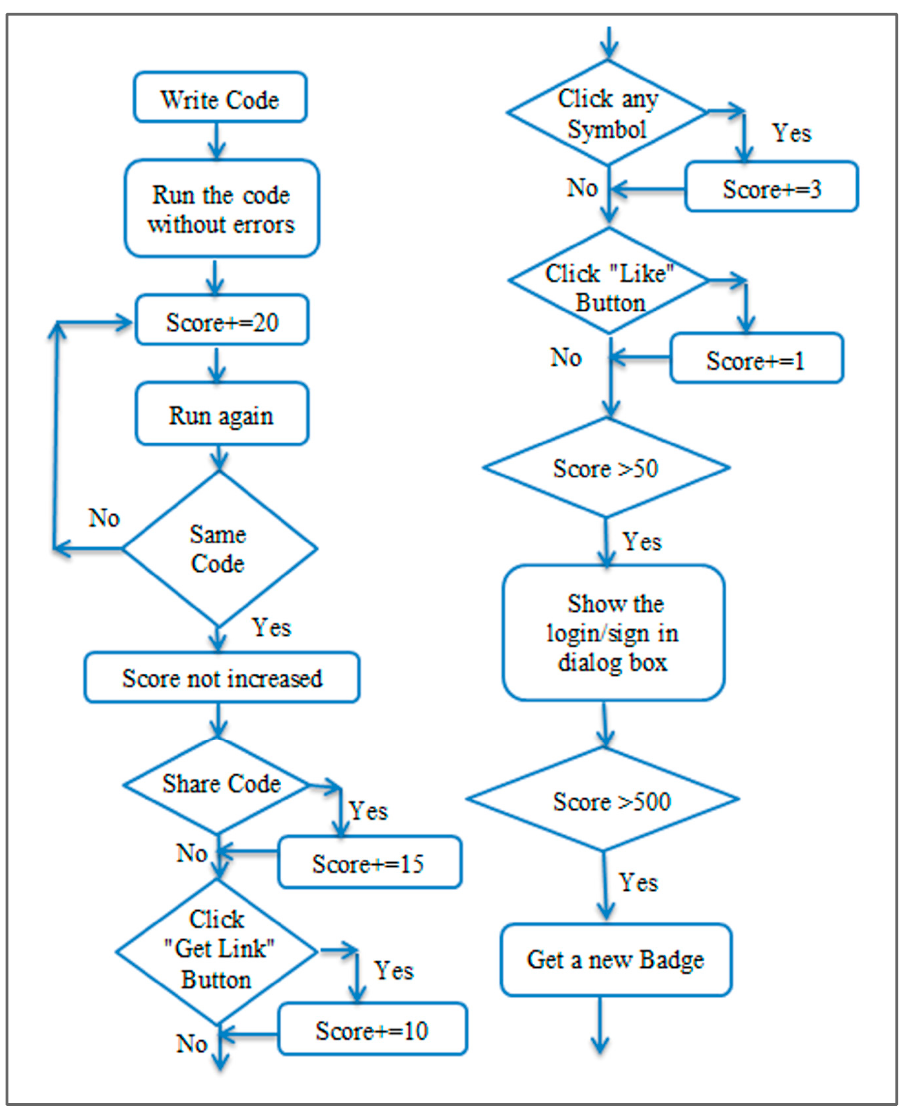
Figure 8. Code Genie Gamification Flowchart.